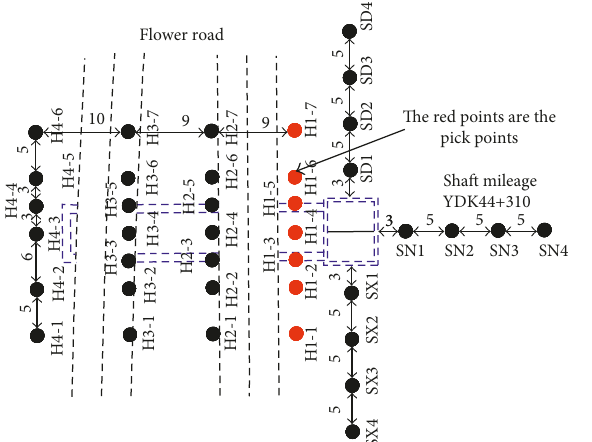
Figure 14: Layout of deformation measuring points at ground surface.